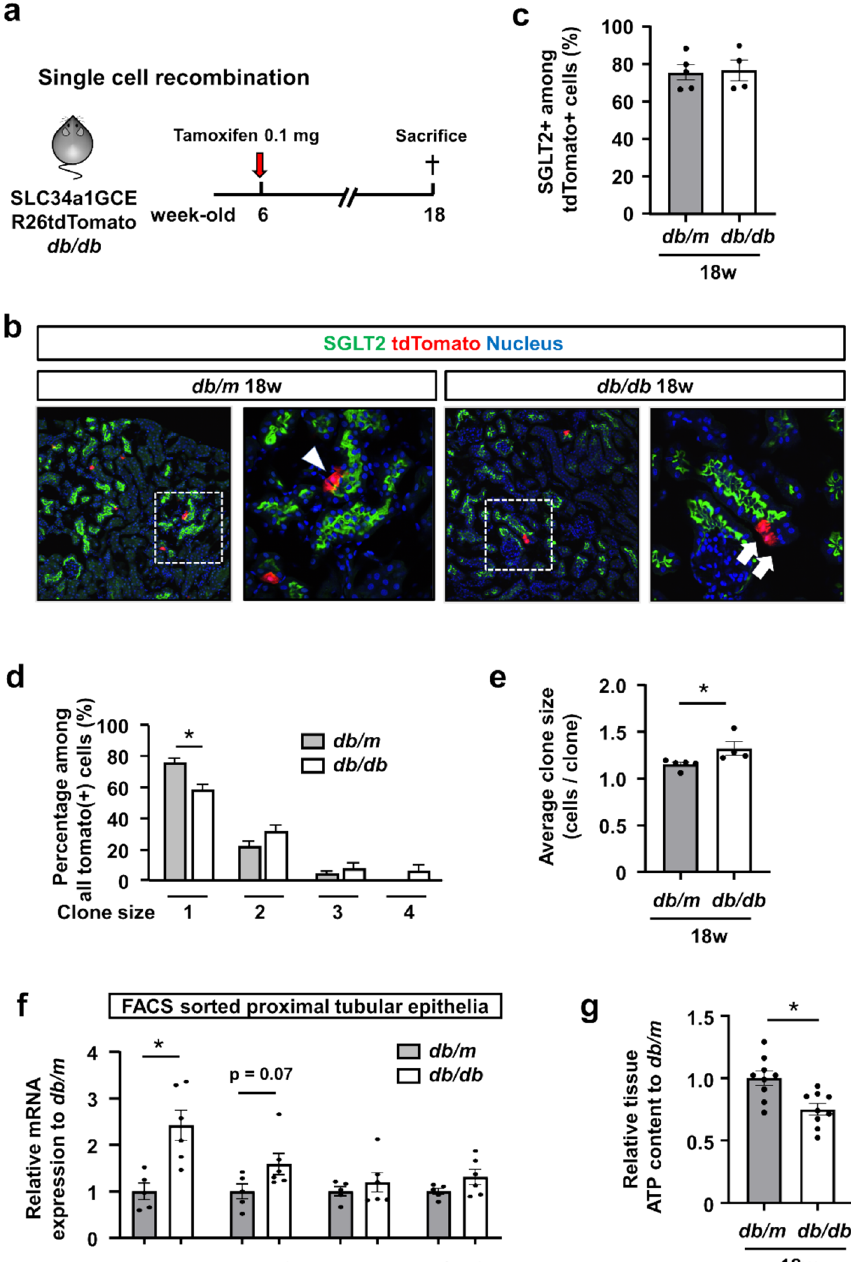
Figure 4. Clonal analysis of proximal tubular epithelial cells in db/db mice. ( a ) Experimental scheme. Single proximal tubular epithelial cells are labeled in SLC34a1GCE R26tdTomato db/db or db/m mice by low-dose tamoxifen injection at 6 weeks of age. ( b ) Representative images of immunostaining of SGLT2 (green) in db/m and db/db mice at 18 weeks. There was expansion of single tdTomato+ clones in db/db mice (arrows), whereas the majority of tdTomato+ cells remained as single-cell clones in db/m (arrowhead). ( c ) Rate of SGLT2 positivity among tdTomato+ epithelia. ( d ) Analysis of clone size and their frequency. Reduction of the frequency of single- cell clones and an increase in multicellular clones were observed in db/db mice. ( e ) The average clone size was larger in db/db mice. ( f ) qPCR of RNA from isolated tubular epithelia for the representative cell cycle markers. ( g ) Renal cortical tissue ATP level. For all groups, data are means ± SEM, *p < 0.05, Bar = 100 μm in ( B